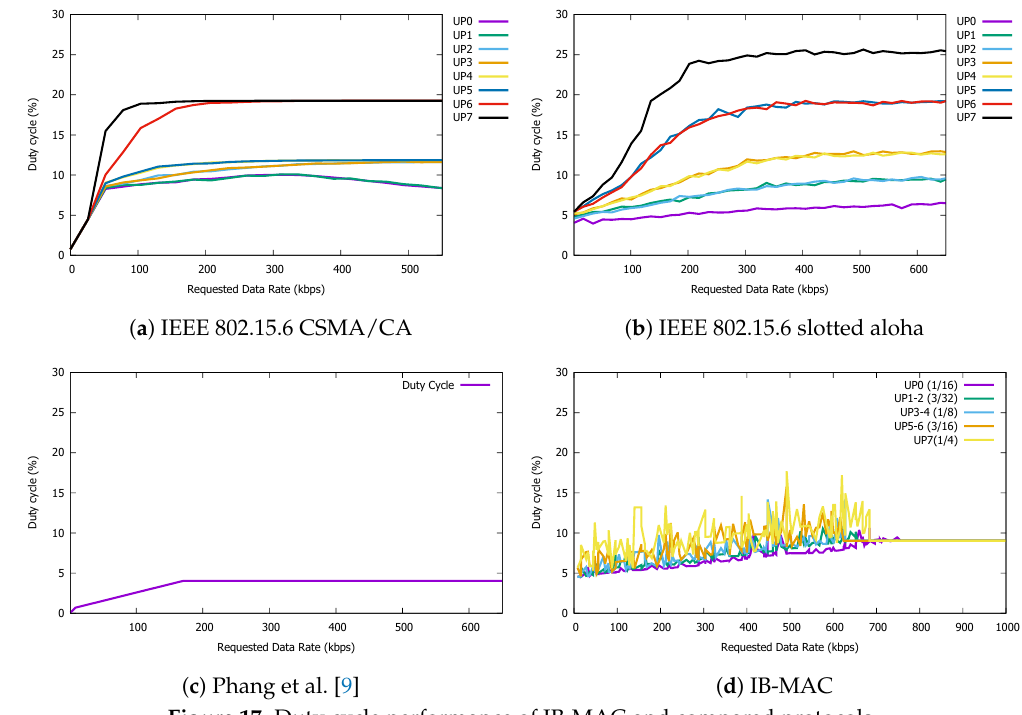
Figure 17. Duty cycle performance of IB-MAC and compared